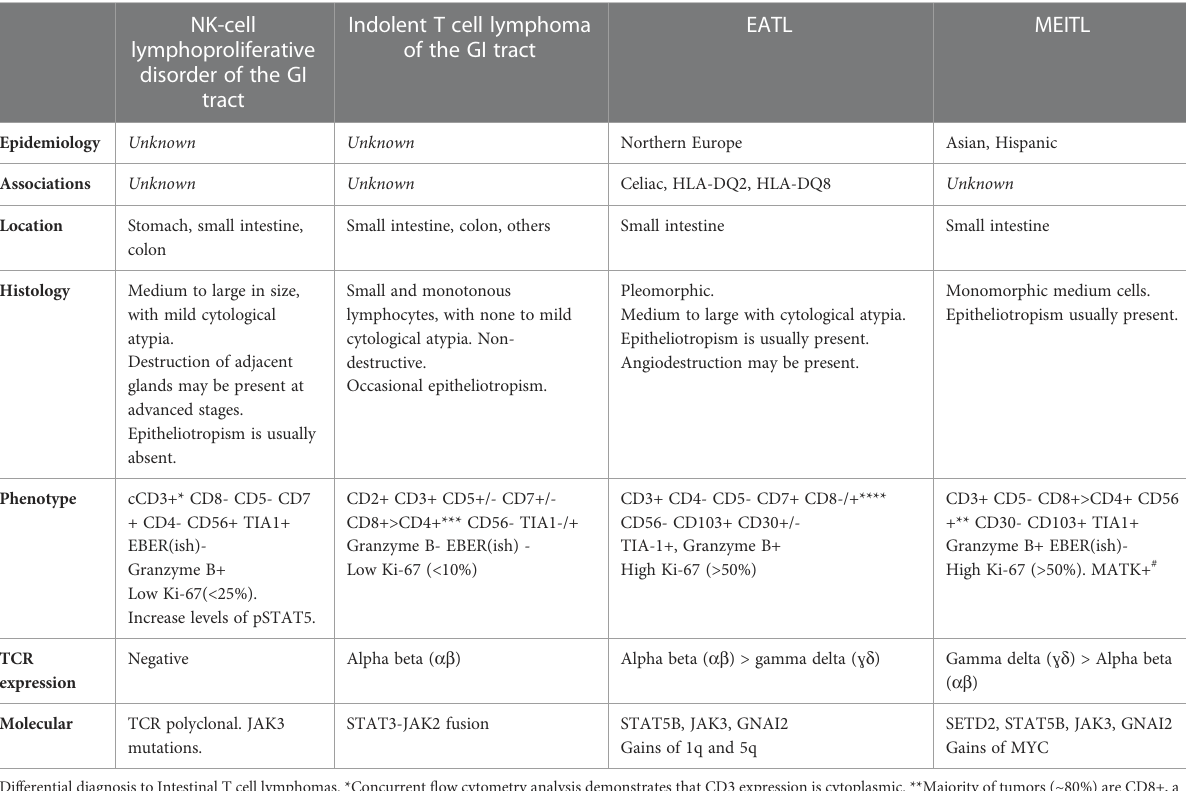
TABLE 3 Histological and molecular features of intestinal T-cell lymphomas. Adapted from Osmani et al. (27).